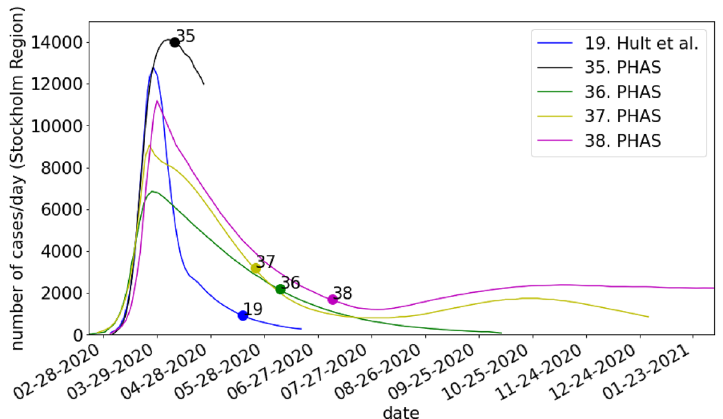
Figure 2. Comparison of the predicted incidence of COVID-19 cases/day in Stockholm Region. The circles on the curves show the date up until which data was used for calibrating the model. No consistent data on the number of factual cases for the entire time period exist.